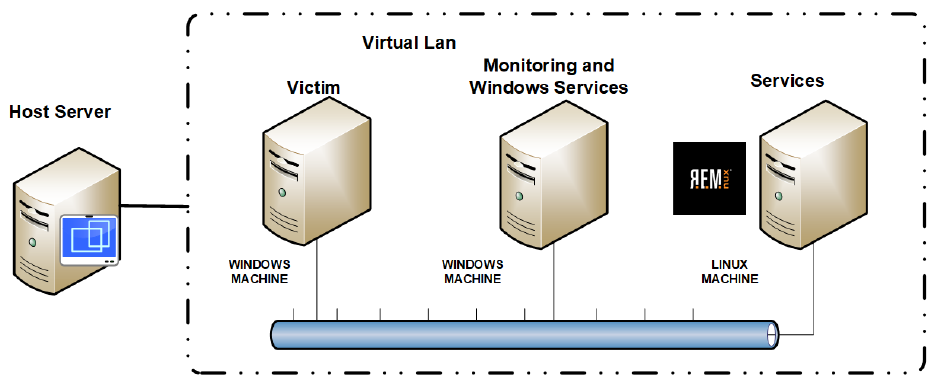
Figure 10. Working environment.